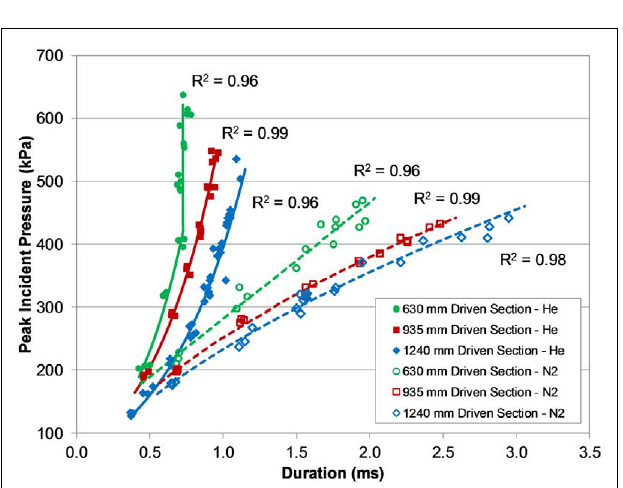
FIGURE 6 | Peak incident pressure measurements across the diagonal of the shock tube (1240mm helium-driven tube shown), showing consistent pressure levels characteristic of a planar shock wave at the end of the tube.